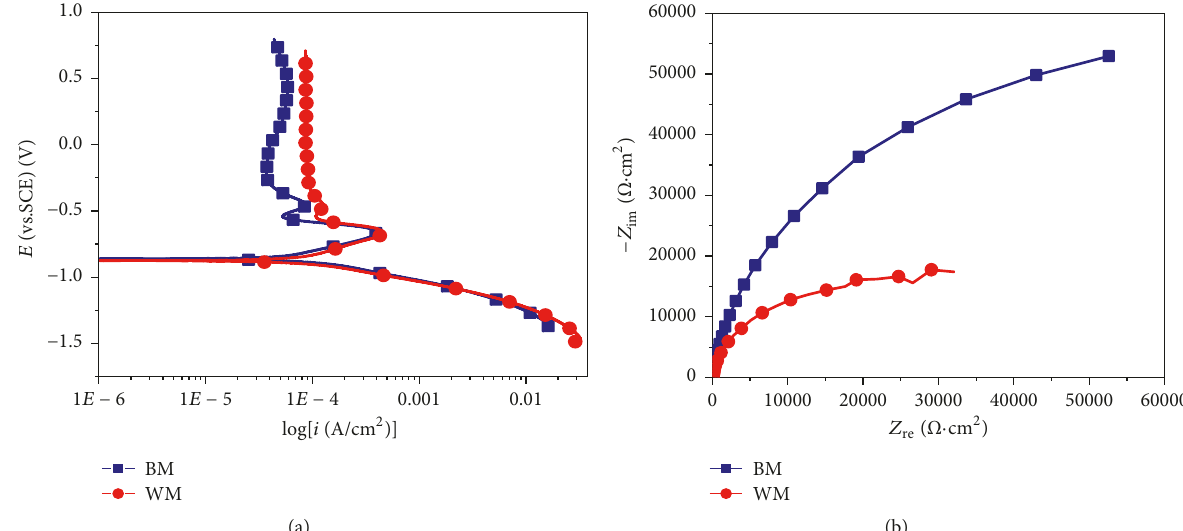
Figure 7: Results of electrochemical corrosion test of BM and WM in the high pH solution. (a) Polarization curves and (b)